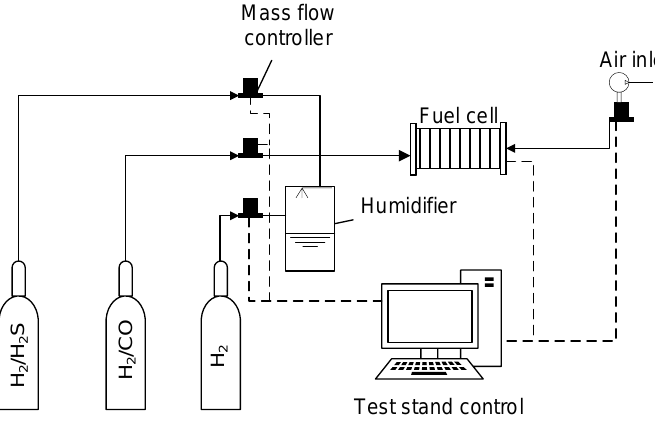
Figure 2. A schematic of the setup used in these